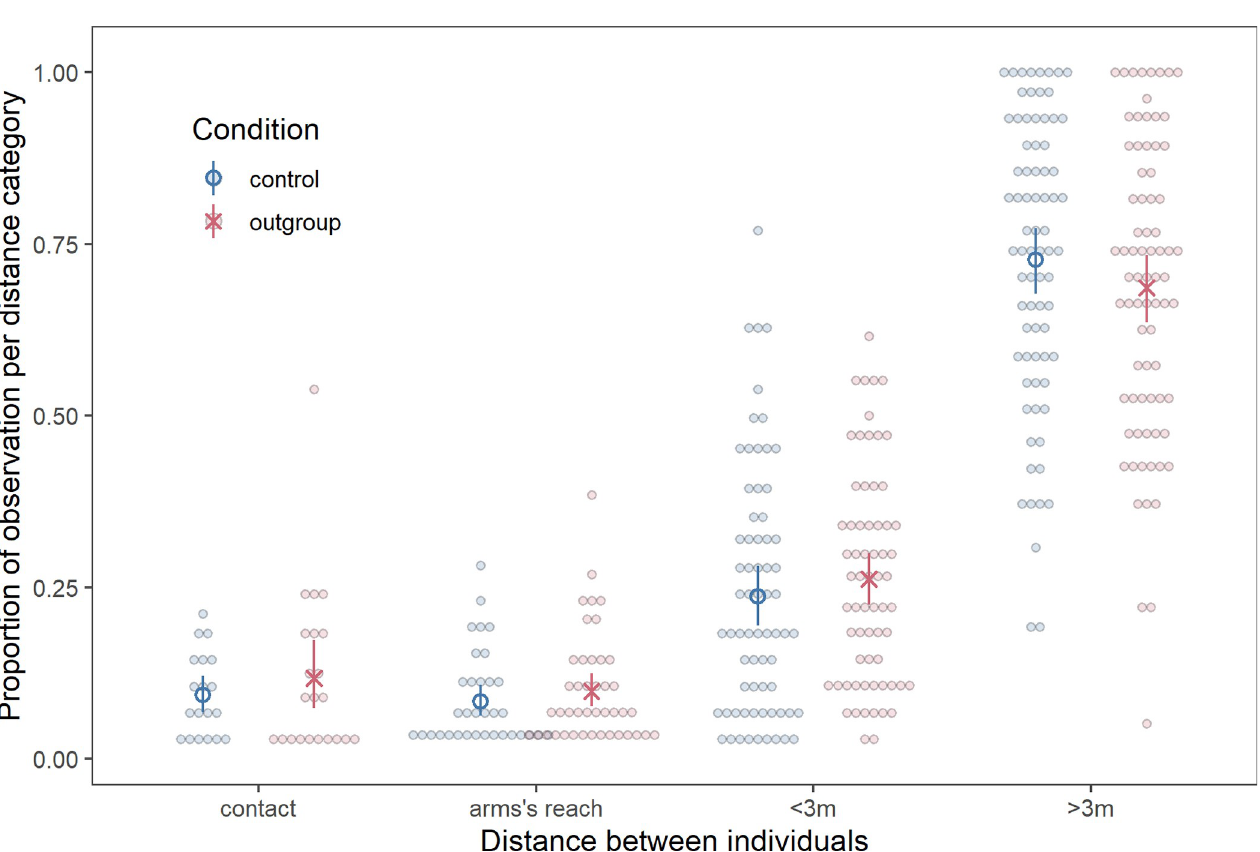
Fig 1. Proximity in the playback phase. Proportion of observations in each proximity category in the outgroup and control conditions. Each dot represents a dyad, blue circles represent the mean for the control condition, and red X’s represent the mean for the outgroup condition. Red and blue bars represent 95% confidence intervals around the mean (based on a non-parametric bootstrap of the